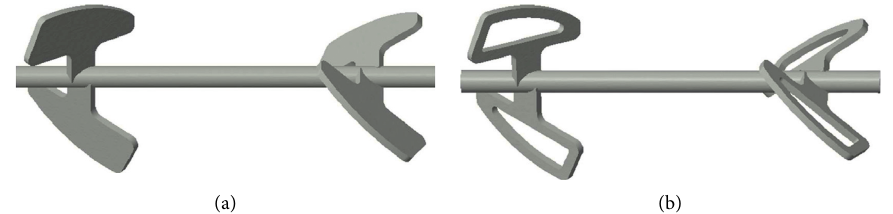
Figure 22: The (a) initial stirring blade and (b) optimized stirring blade.